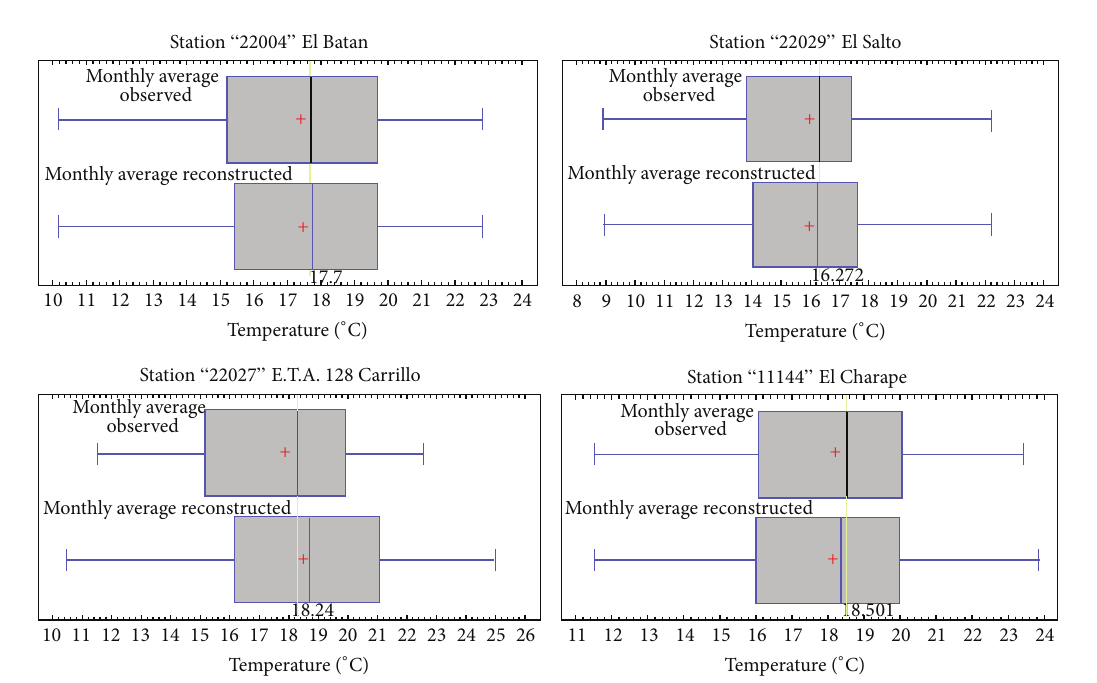
Figure 6: Observed and reconstructed data in a boxplot